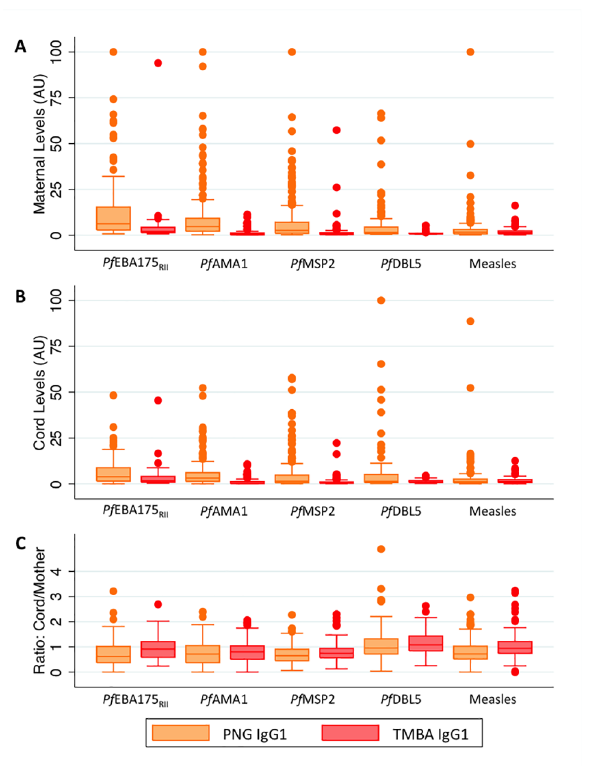
Fig 1. Maternal and cord IgG1 levels by study site. (A) Maternal IgG1 levels (arbitrary units) by study site. (B) Cord IgG1 levels (arbitrary units) by study site. (C) Cord:maternal IgG1 ratio by study site.